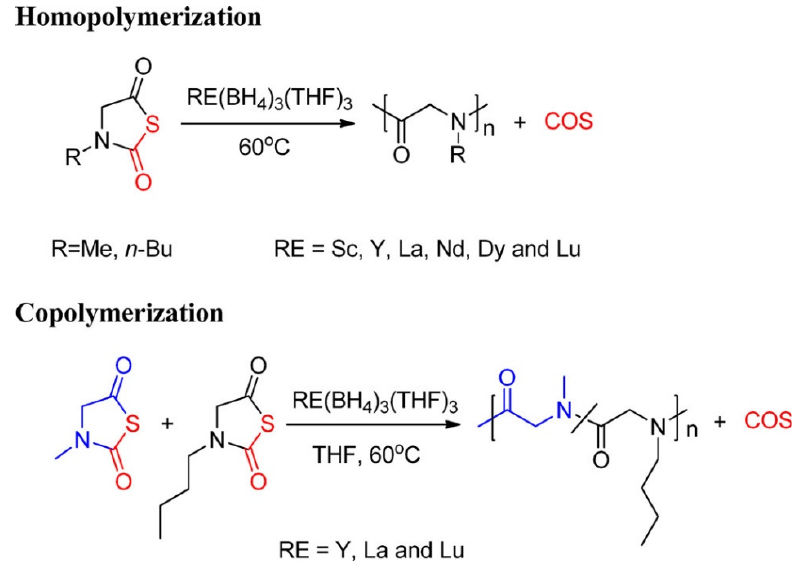
Figure 17. Polymerization of Sar-NTA and NBG-NTA initiated by RE(BH 4 ) 3 (THF) 3 (Adapted from ref. [97]. Copyright 2014, American Chemical Society).